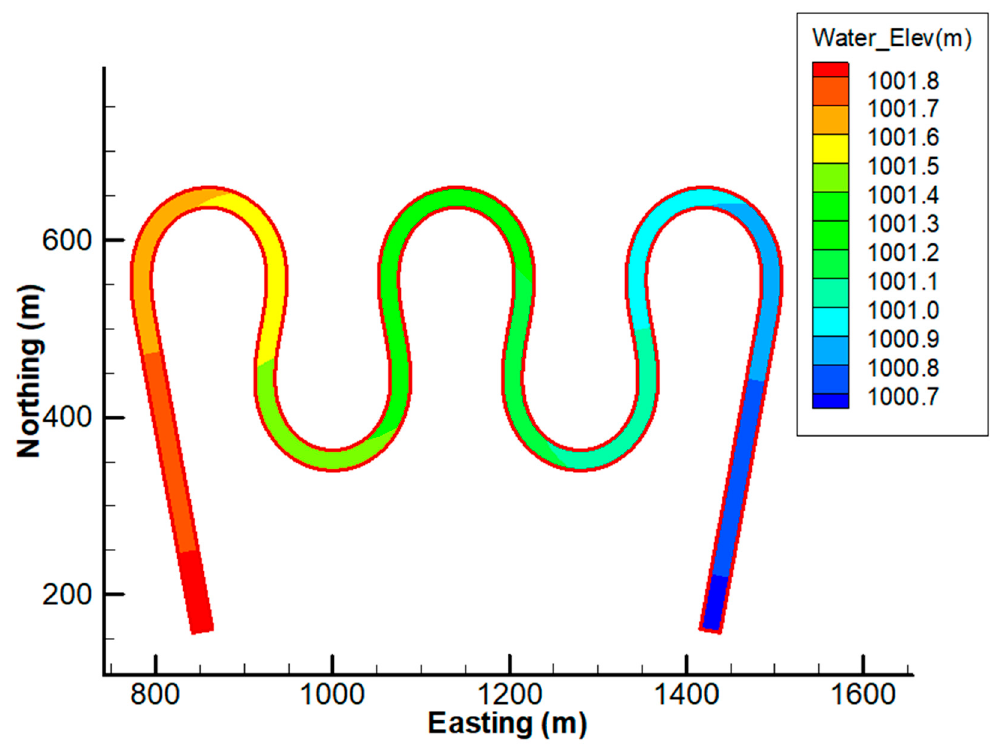
Figure 24. Close-up plan view of the structured two-dimensional (2D) model mesh for Simulation Set 5 with a sinuosity of 2.75.